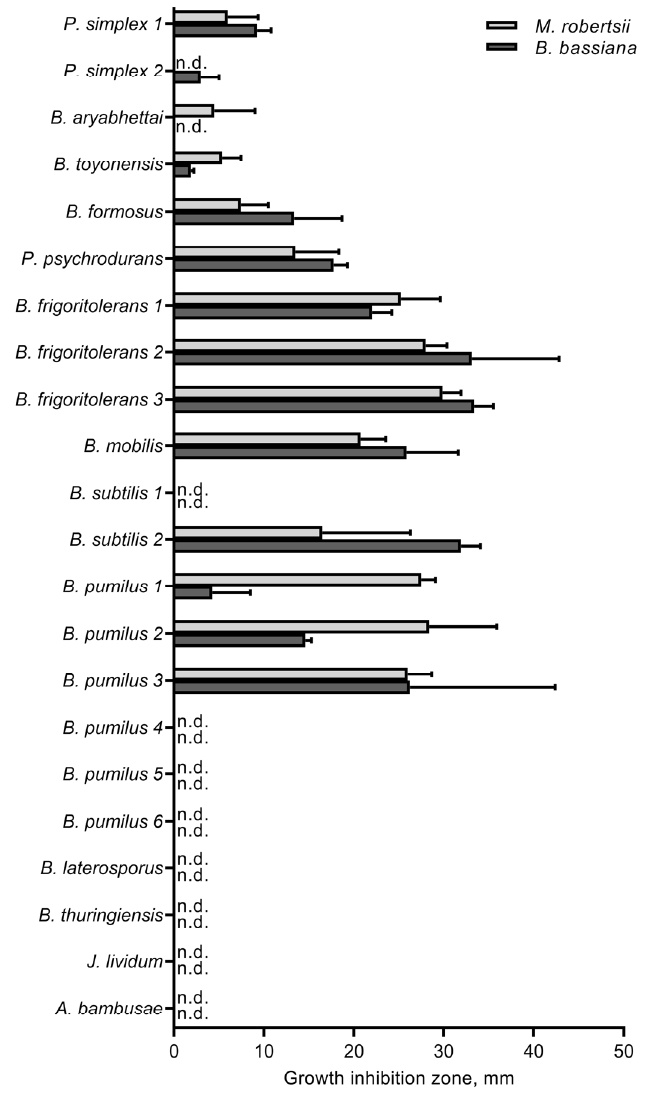
Figure 3. Antagonistic action of soil bacteria against entomopathogenic fungi M. robertsii and B. bassiana, as estimated by the agar plug diffusion method. n.d.: an inhibition zone was not detectable.